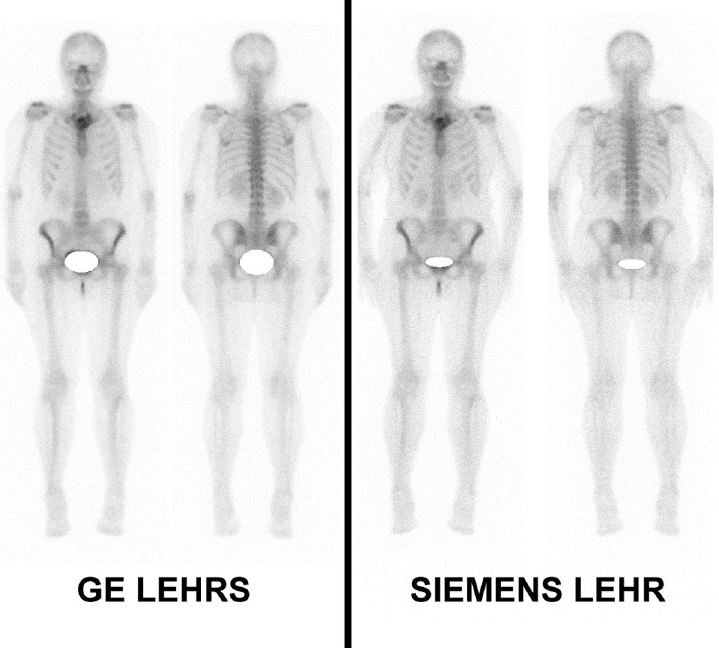
Fig 4. Whole body scan acquisitions in bone scintigraphy. Visually, heterogeneity in soft tissues is more important on Siemens LEHR images with more granulations in images. On quantification, with a 400 pixels region of interest on left axillary soft tissues, the standard deviation was measured at 1.79 for GE Swiftscan LEHRS and 2.72 for Siemens Symbia LEHR. We also observe a better delineation of each lumbar vertebra and left sternoclavicular joint with GE Swiftscan